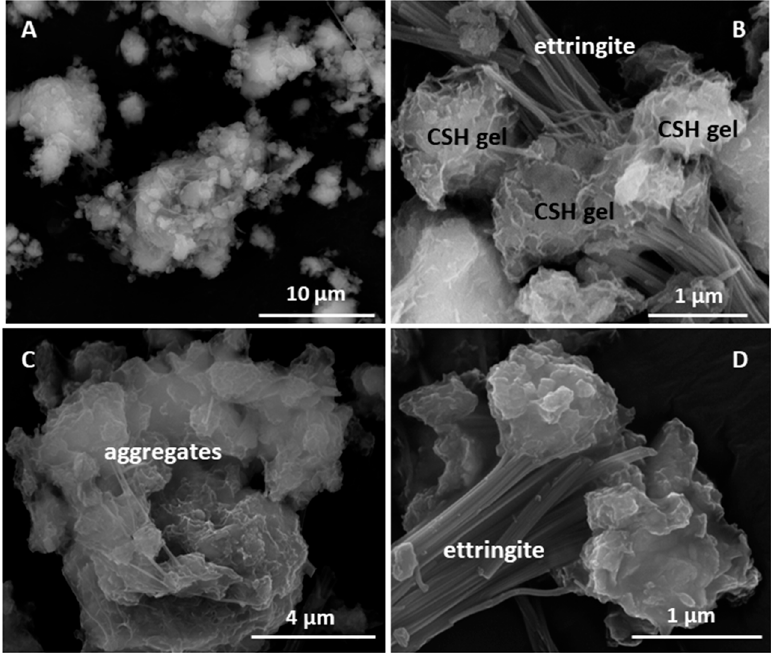
Figure 14. ( A ) Overview of HcG; ( B ) ettringite and C–S–H gel in HcG, detail; ( C ) overview of aggregates in HcC; ( D ) ettringite in HcC. Table 7. EDX chemical analysis of 1 day HcG waste / lime